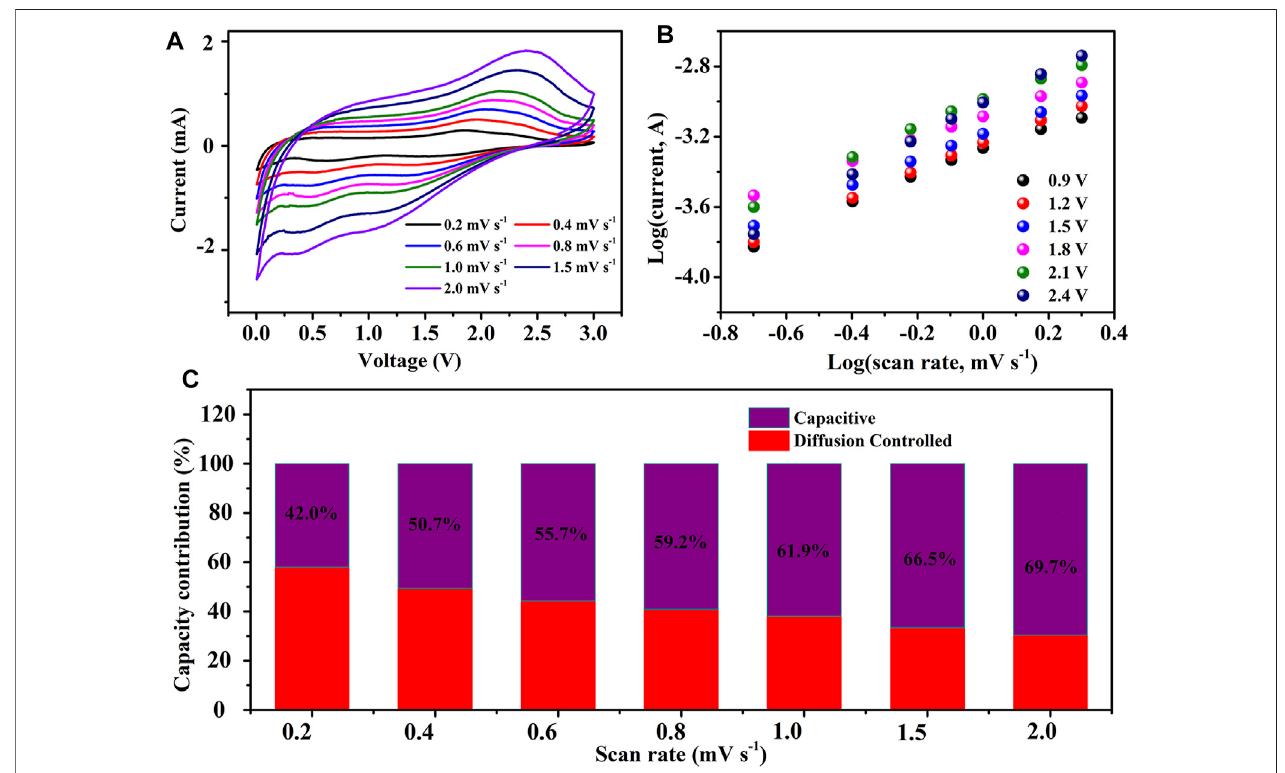
FIGURE 10 | Electrochemical behaviors of F-MoS 2 @NC as anode of SIBs: (A) CV curves of F-MoS 2 @NC-0.8 electrode at different sweep rates. (B) Linear relationship between log( i ) and log( v ) of F-MoS 2 @NC-0.8 electrode at different voltage. (C) Ratios of pseudocapacitive and diffusion controlled contributions at different sweep